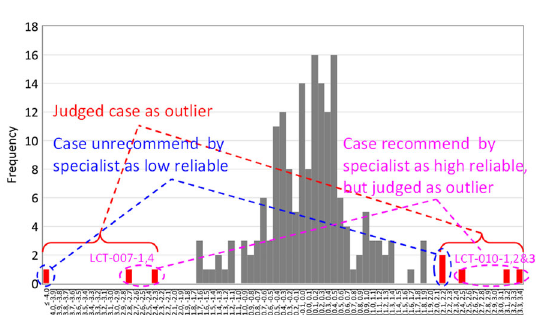
Fig. 2 . E'/E-1 of keff.